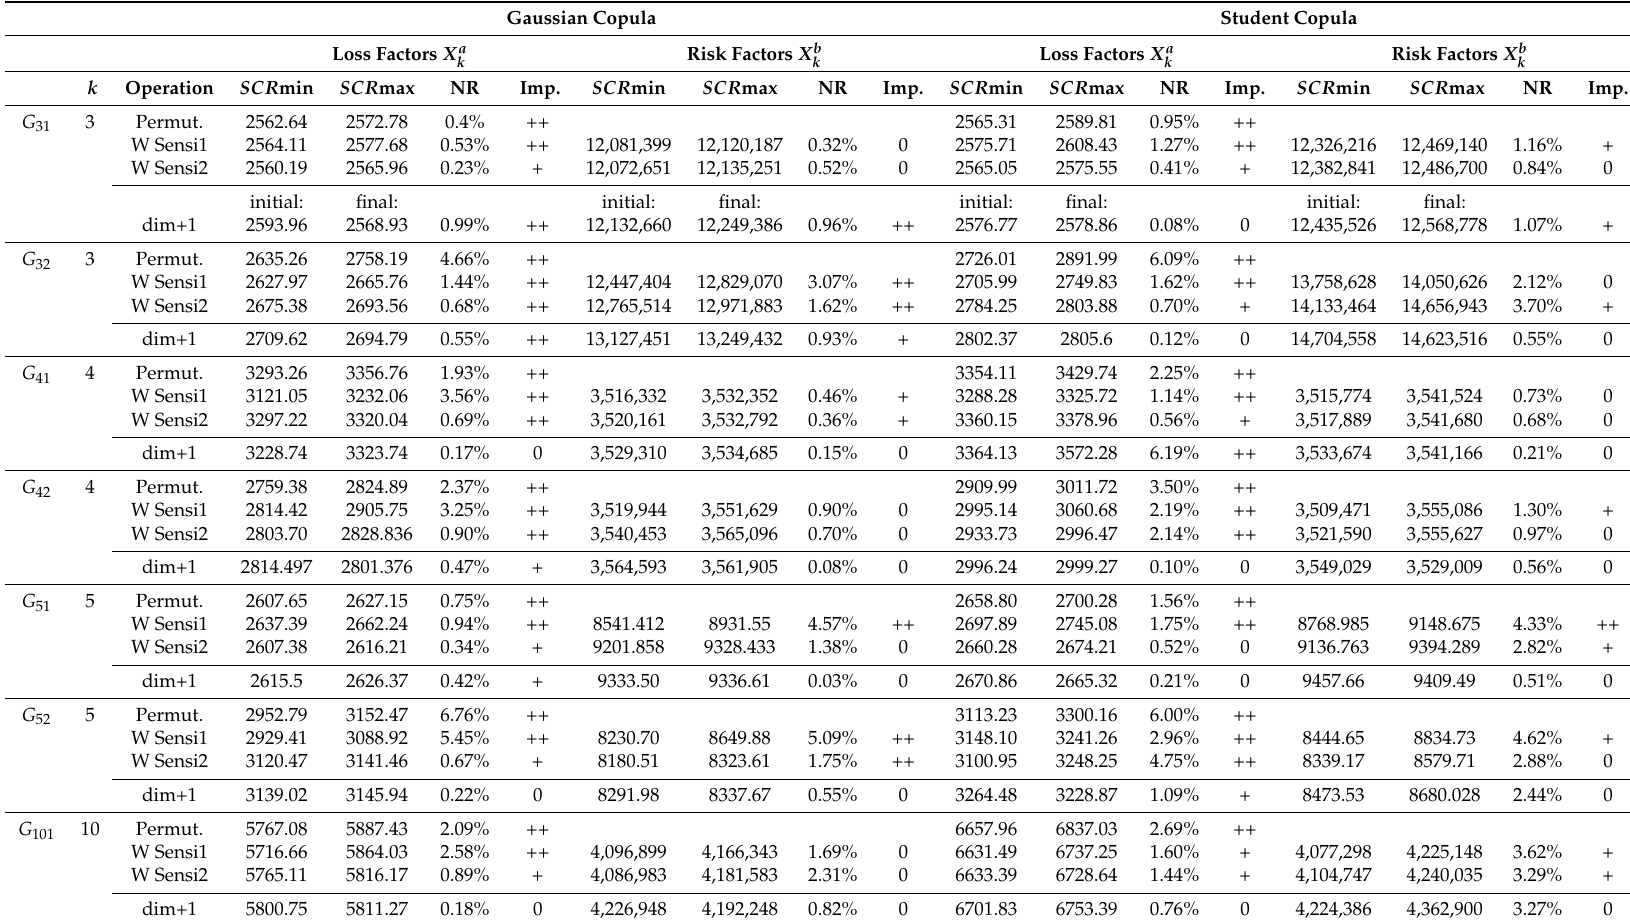
Table 9. Sensitivities of the global SCR to transformations on the correlation matrix (permutation, two different cases for weighting the correlation coefficients, and addition of a new risk), depending on copula, and type of aggregation (risk factors/loss factors). Column ‘Imp.’ describes the strength of the impact of the transformation under study: ‘0’ refers to a limited impact ( NR < 2 × 1.65ˆ σ , see (2)), ‘+’ means a significant impact ( NR ∈ [ 2 × 1.65ˆ σ ,2 × 2.89ˆ σ ] ), and ‘++’ a very strong impact ( NR > 2 × 2.89ˆ σ